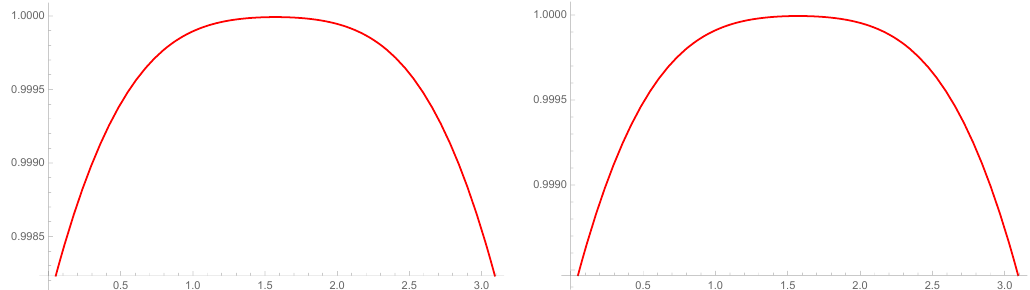
Figure 5. Percentage of the contribution to the Green’s function from the continuous spectrum. The computation is done at β = π , C = 1 . The left panel is for the even N case; the right panel is for the odd N